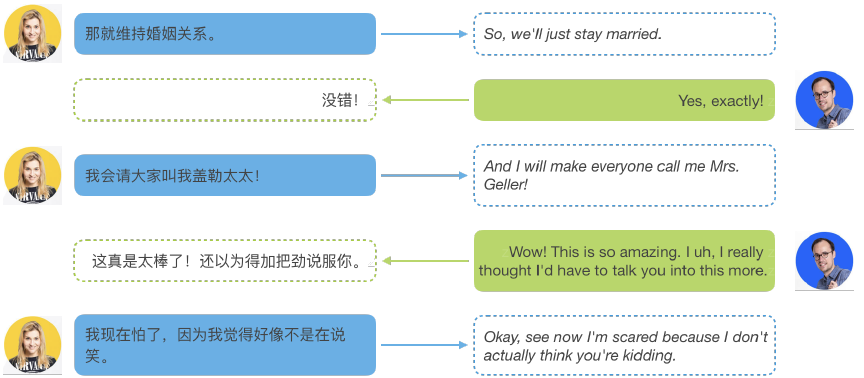
Figure 2. An example of chat-based dialogue translation. It is extracted from the Chinese-English MVSub Corpus.